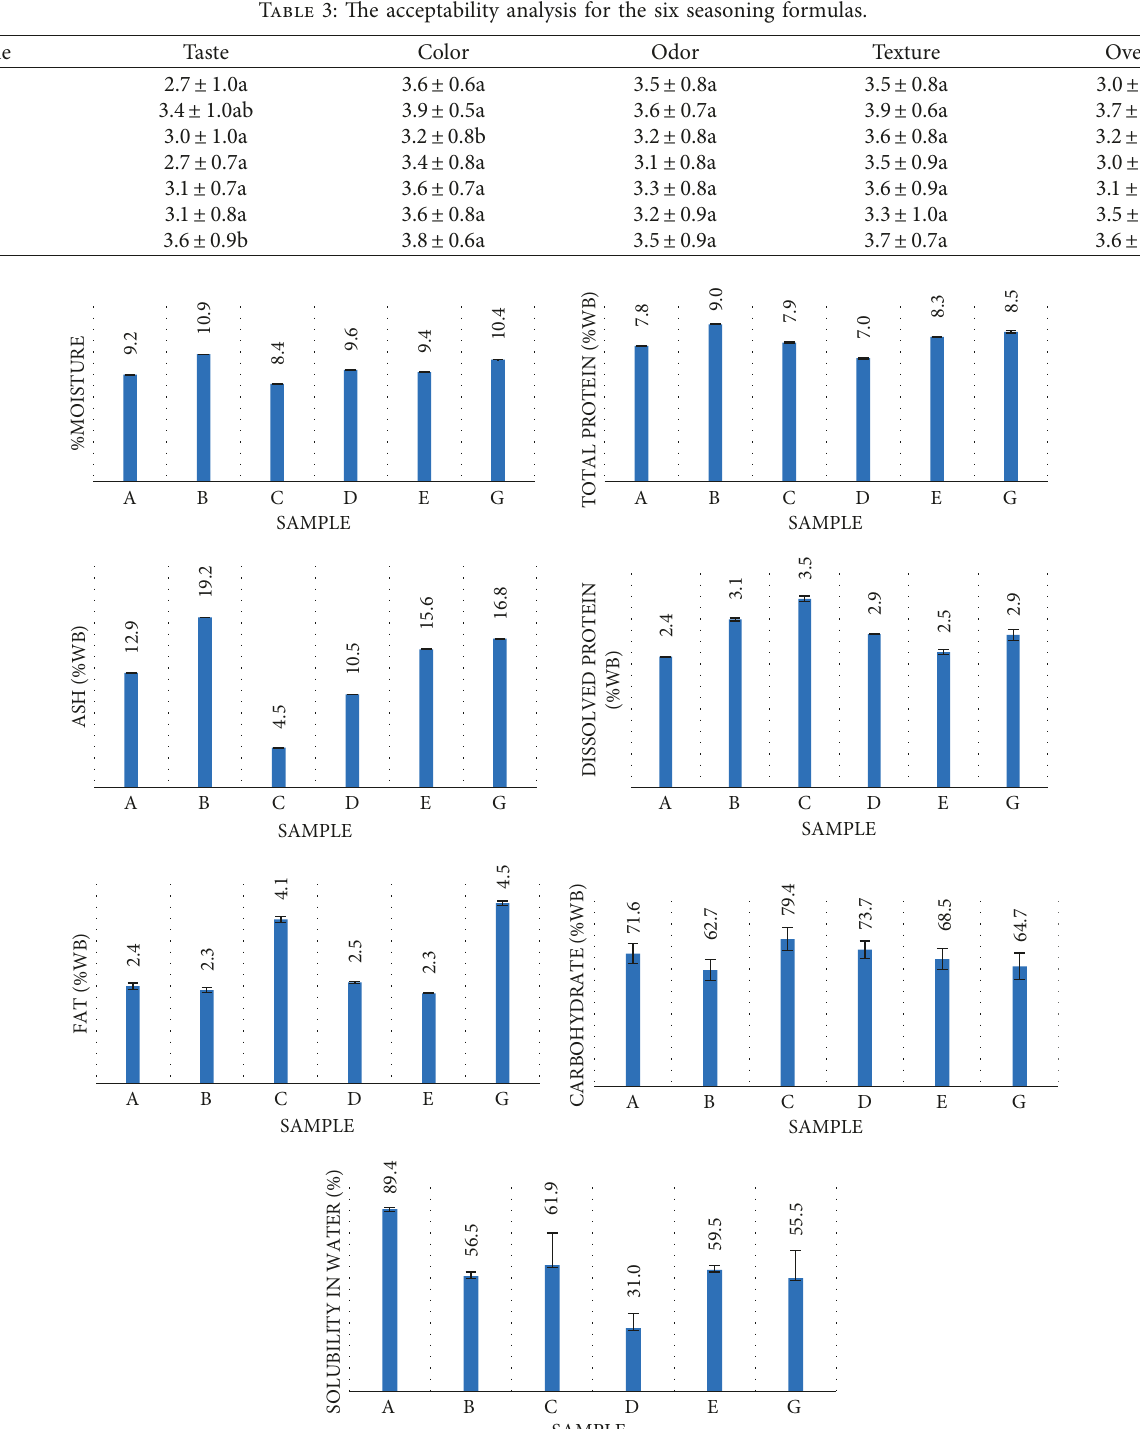
Table 3: The acceptability analysis for the six seasoning